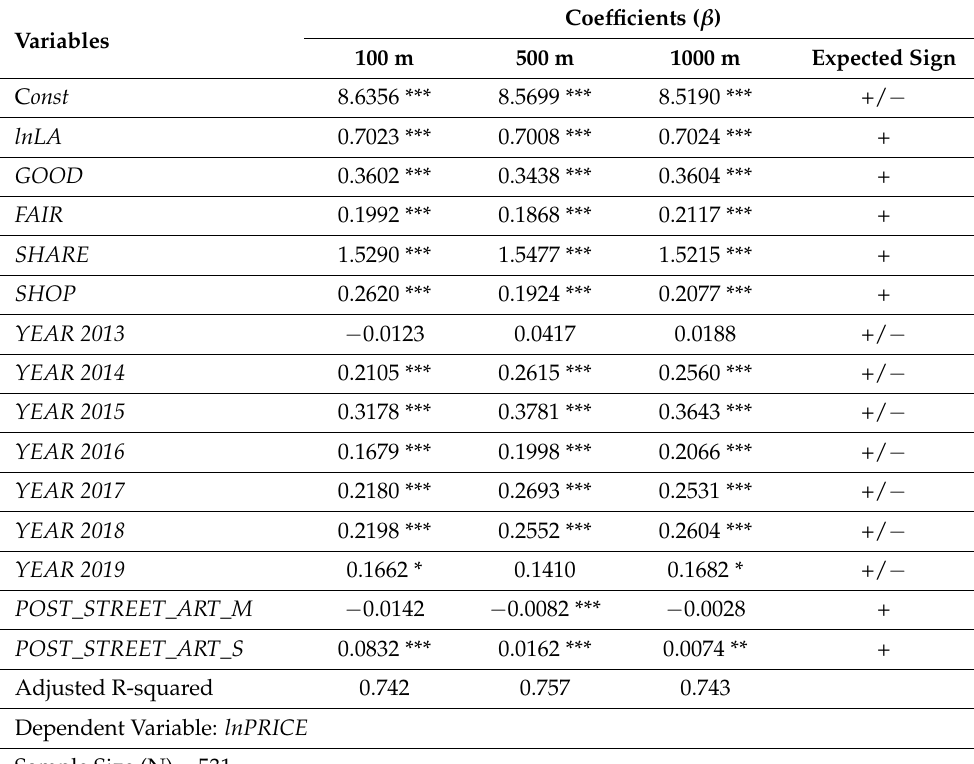
Table 9. OLS Regression Results of Model